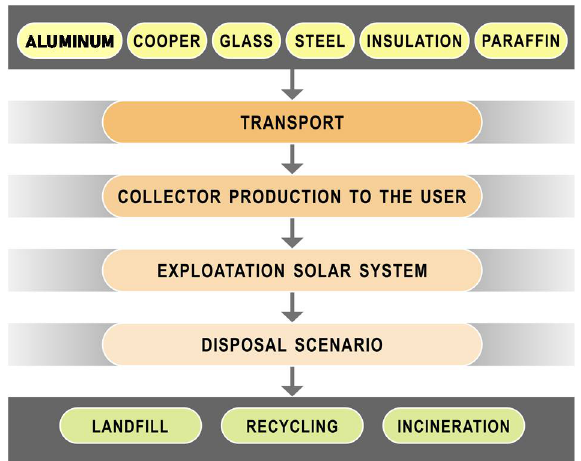
Figure 2. Scheme of the analysis object and material data used for LCA. Variant 1: basic ETC